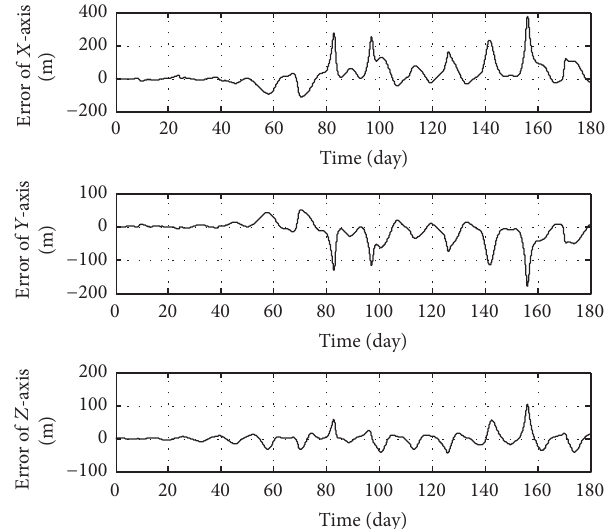
Figure 11: The AOD position error of 𝐿 1 using SR-EKF with 𝑃 0 = 10 −10 .